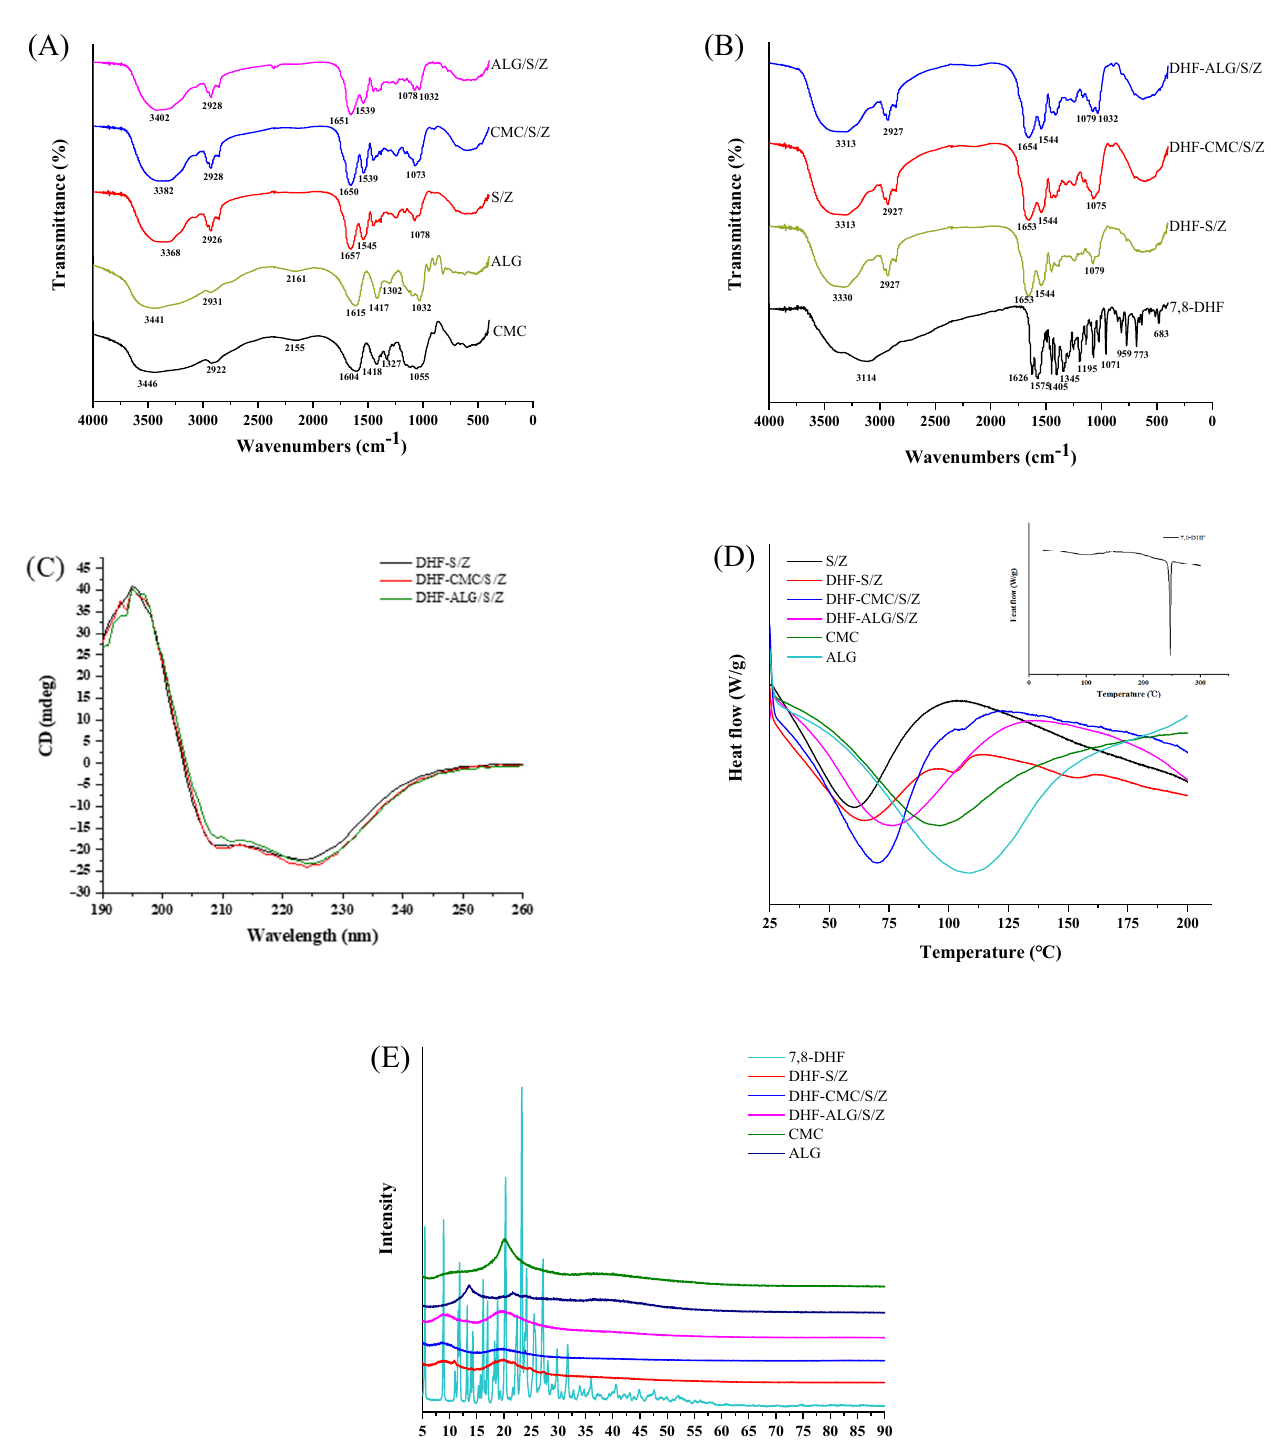
Figure 4. FTIR spectra of CMC, ALG and bare complex nanoparticles ( A ), free 7,8-DHF and 7,8-DHF loaded in each complex nanoparticles ( B ), CD spectra of zein in DHF-Z, DHF-Z/S-CMC, and DHF-ALG/S/Z ( C ), DSC analysis of free 7,8-DHF, CMC, ALG, S/Z, and 7,8-DHF loaded each complex nanoparticles ( D ), XRD spectra of free 7,8-DHF, polysaccharides and loaded each complex nanoparticles ( E ).